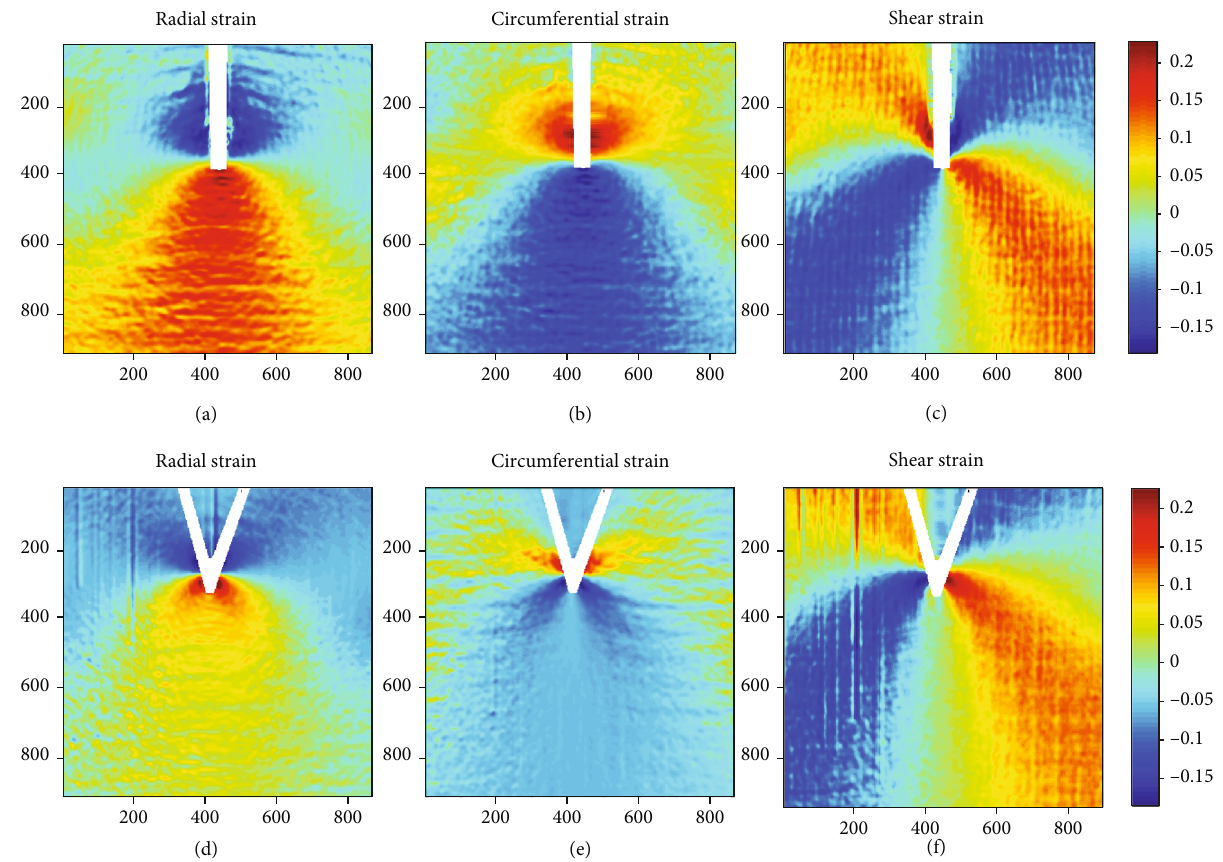
Figure 4: Strain fi elds of bionic skin under polar coordinate system. Units: %.